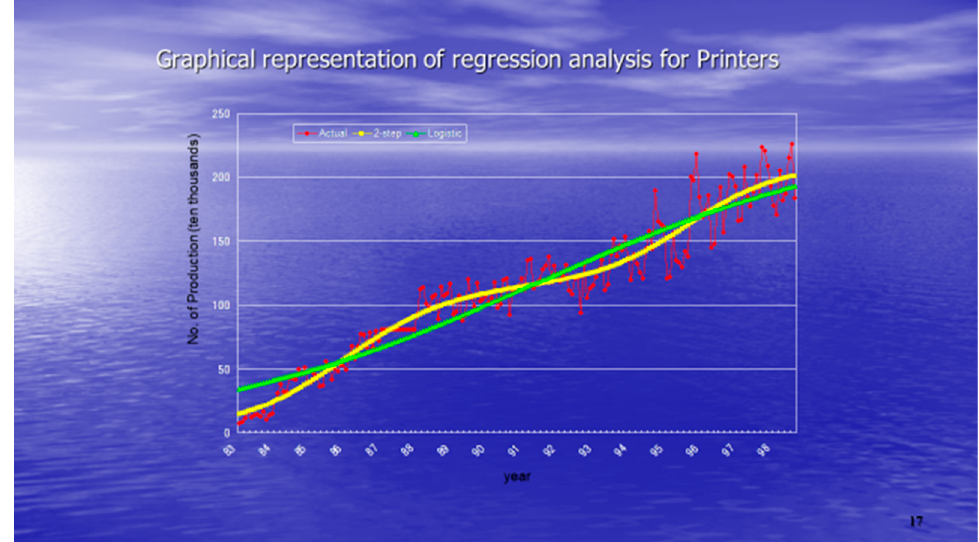
Figure 9. Graphical representation of regression analysis for printers. Source: Osaki et al. (2001) [26].